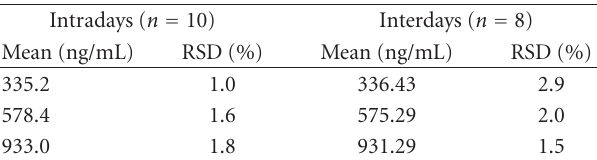
Table 2: Precision of the method with dilution of urine samples